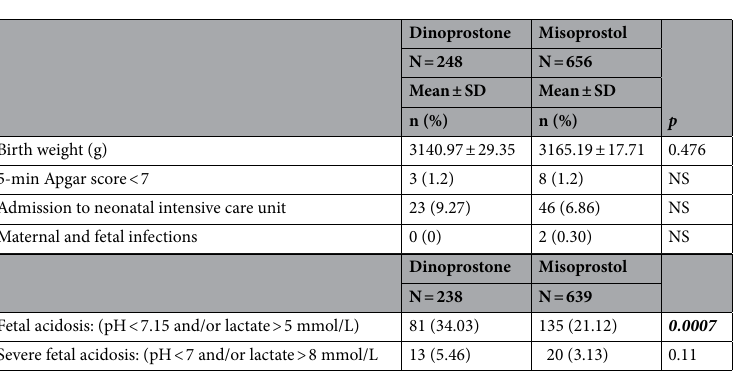
Table 7. Characteristics of newborns and neonatal morbidity. NS = Non-significant. Significant values are in